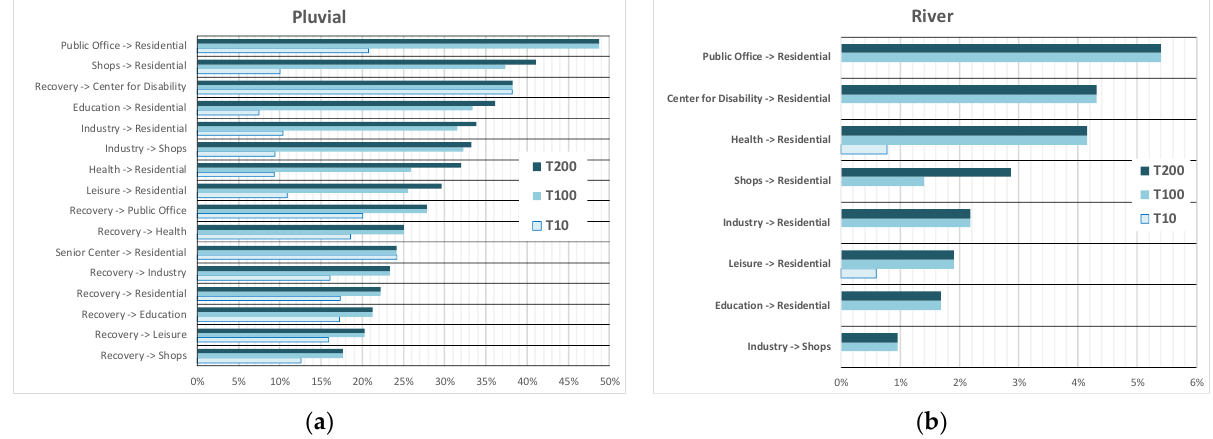
Figure 7. Economic service accessibility impact: ( a ) pluvial flood; ( b ) river flood.